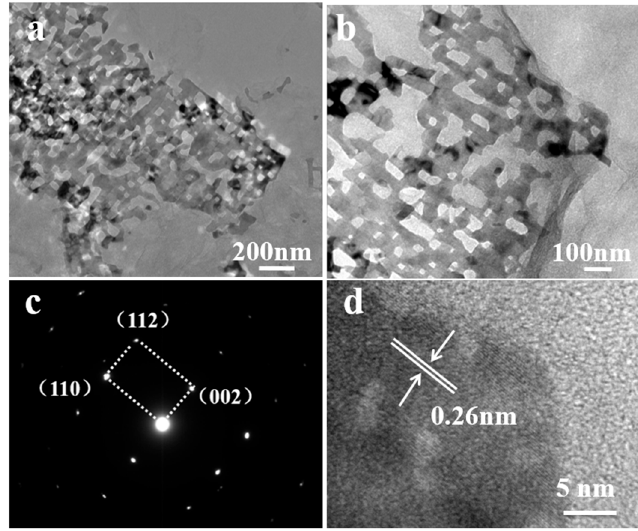
( d ) HRTEM image of GO/ZnO nanosheets.